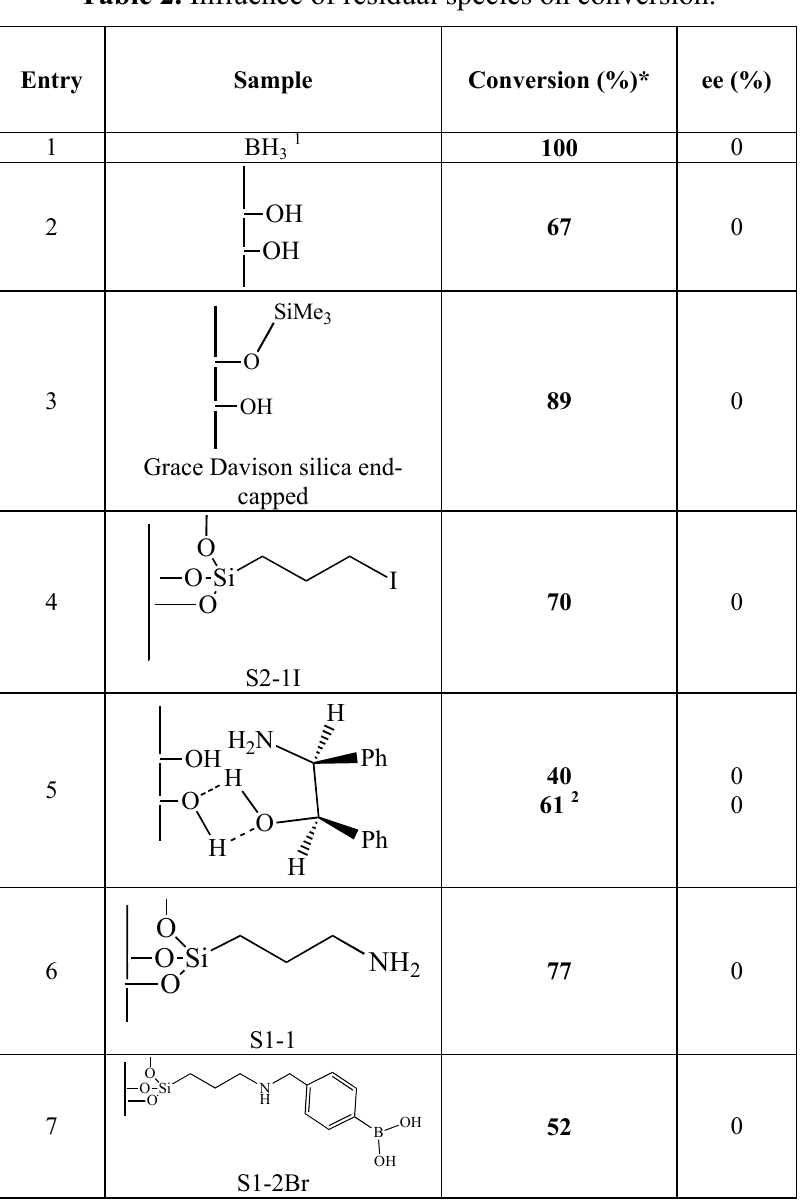
Table 2. Influence of residual species on